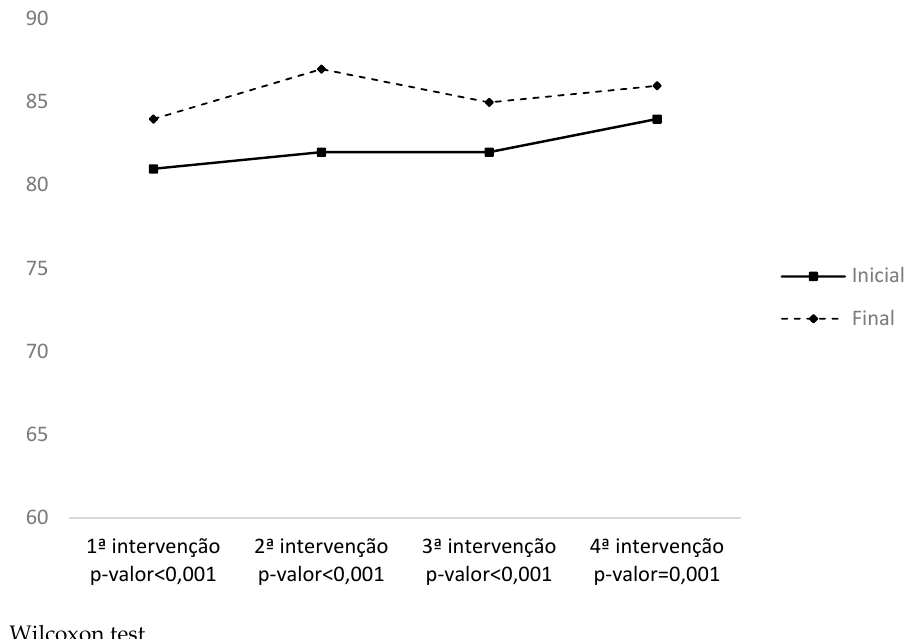
Figure 7. Median values of diastolic blood pressure (DBP) before and after the four interventions in the CG (educational activity).